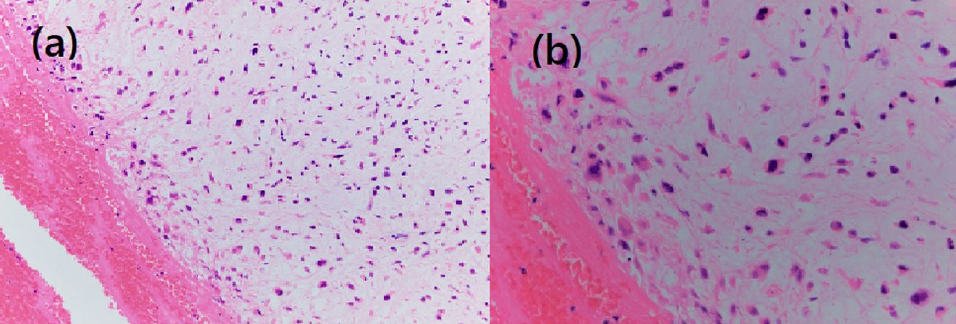
Fig. 7 Atypical spindle cells are suspended in a chondromyxoid matrix. Tumor cells show hyperchromatic pleomorphic nuclei. a